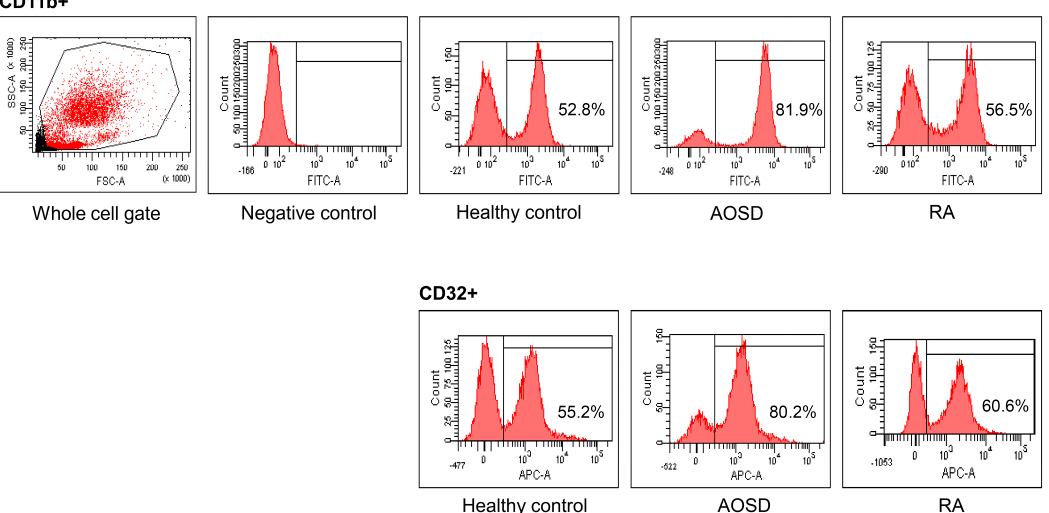
Figure 1. Representative examples of flow cytometric histograms of surface-stained cells presenting several cellular markers from peripheral blood of one patient with adult-onset Still’s disease (AOSD), a patient with rheumatoid arthritis (RA), and a healthy control (HC) are shown. PBMCs were treated with ACK solution to lyse red blood cells (RBCs) and washed with phosphate-buffered saline (PBS), after which 1 × 10 6 cells in each tube were incubated with allophycocyanin (APC)-labeled anti-CD4, fluorescein isothiocyanate (FITC)-labeled anti-CD11b, and APC-labeled anti-CD32, for 30 min at 4 °C. The stained cells were then washed with PBS and analyzed using a flow cytometer (FACSAria III; Becton Dickinson, San Jose, CA, USA) with 10,000 cells.